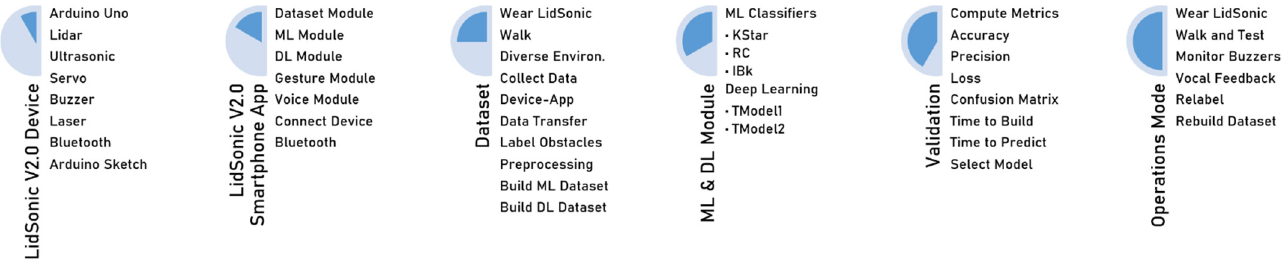
Figure 3. LidSonic: A Developer’s View.